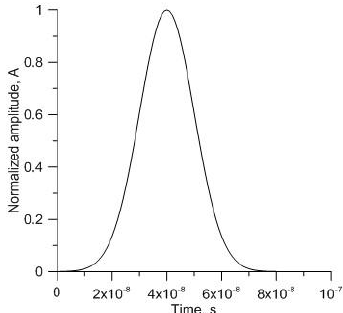
Figure 2. The normalized Gaussian current pulse with standard deviation = 10 ns.